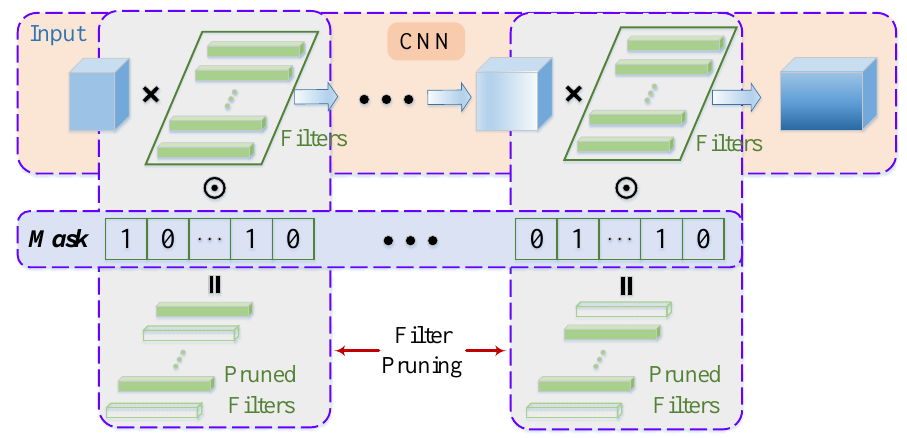
Figure 2. Illustration of filter pruning and evolutionary individual